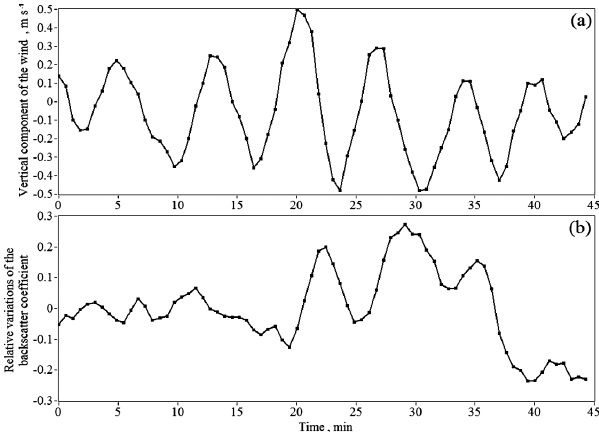
Figure 12. Time dependence of the vertical component of the wind vector (a) and relative variations of the attenuated backscatter coef- ficient (b) obtained from the data depicted in Fig. 11c, d at a height of